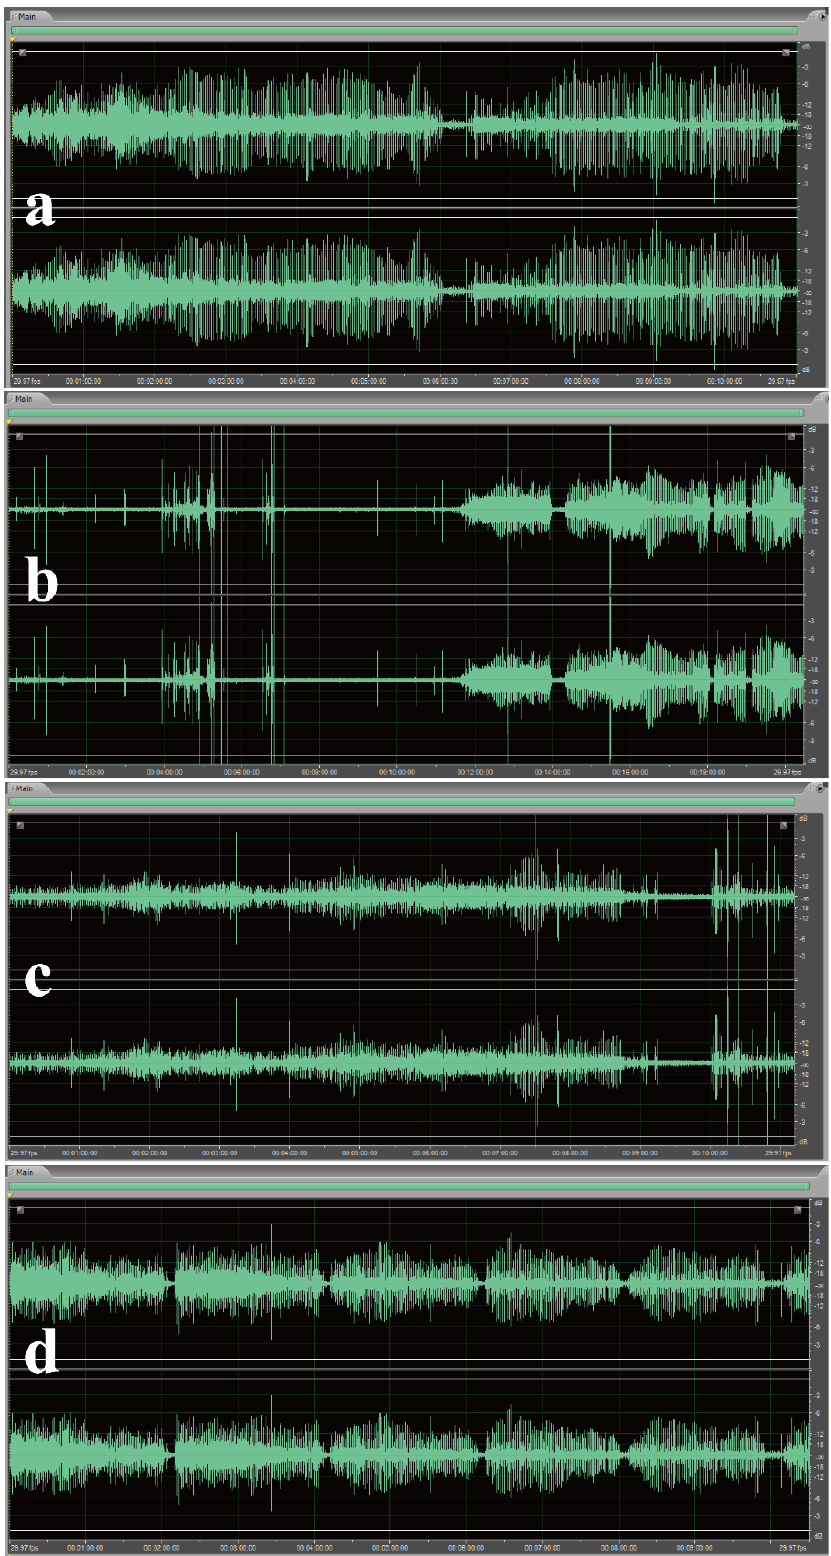
Figure 6. Sound pressure signal in a tribo-acoustic test with different lubricants: DI water ( a ); HA ( b ); HA + BSA ( c ); HA + BSA-NP ( d ). The concentration of HA was 15 mg/mL, and that of the additives was 15 mg/mL (test conditions: ZrO 2 ball-on-plate, a load of 100 N and a frequency of 1 Hz).